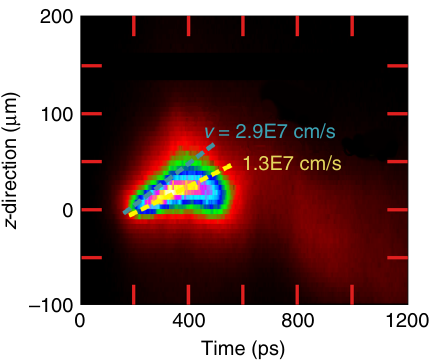
Fig. 10 Plasma expansion visualized by X-ray streak camera. The laser is coming from below, the volume of the maximum emission moves with a velocity of 1 : 3 ´ 10 7 cm =